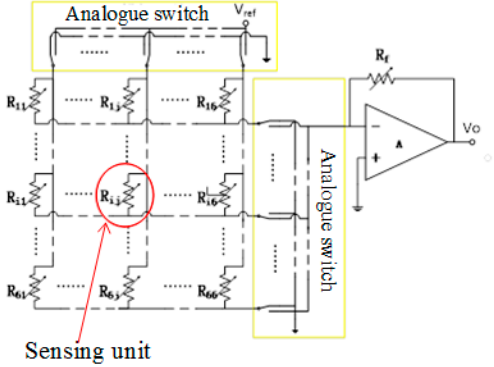
Figure 4. Readout circuit schematic and 6 × 6 example sensor array are presented.